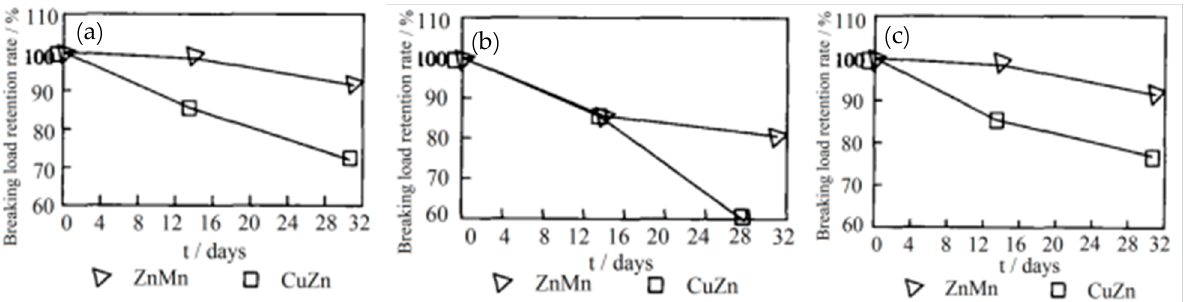
Figure 23. The breaking load drop of Zn-Mn and Cu-Zn-coated steel cord after aging in the high-humidity environment: ( a ) 2 + 3 × 0.28, ( b ) 2 + 1 × 0.28, and ( c ) 0.22 + 6 + 12 × 0.20 (different numbers indicate the combination mode of the steel cord). Reprinted with permission from ref. [55].